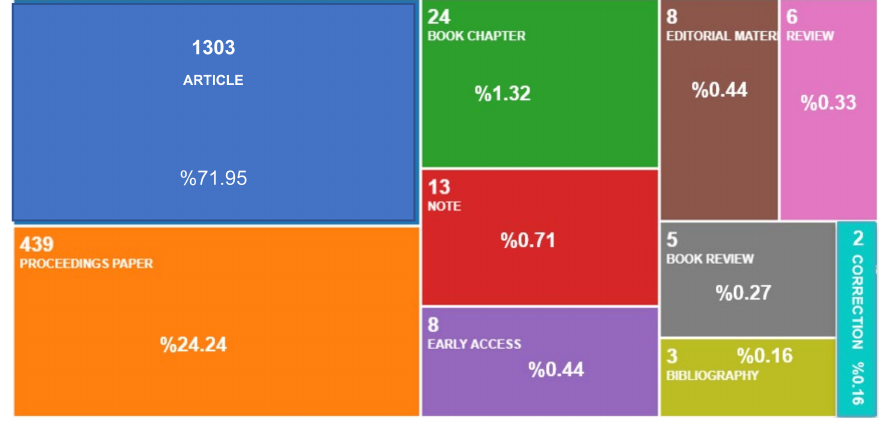
Figure 6. Types of publications related to FP.